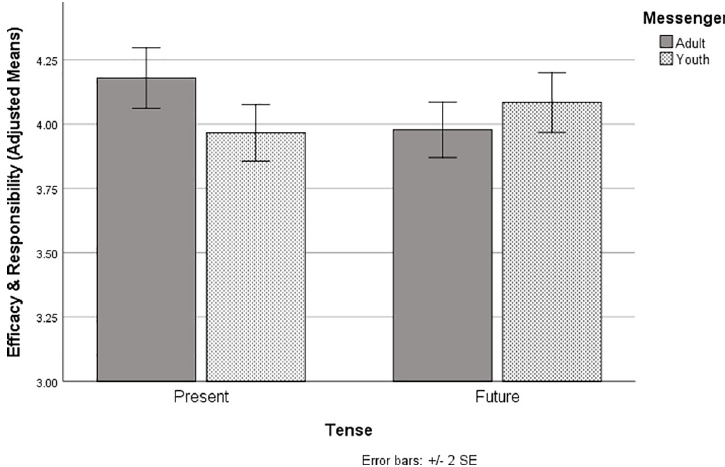
Fig 3. Interaction between messenger and tense of messages on feelings of responsibility and efficacy. Adult messengers using present tense increased efficacy and responsibility more than those using future tense; the pattern was reversed for child